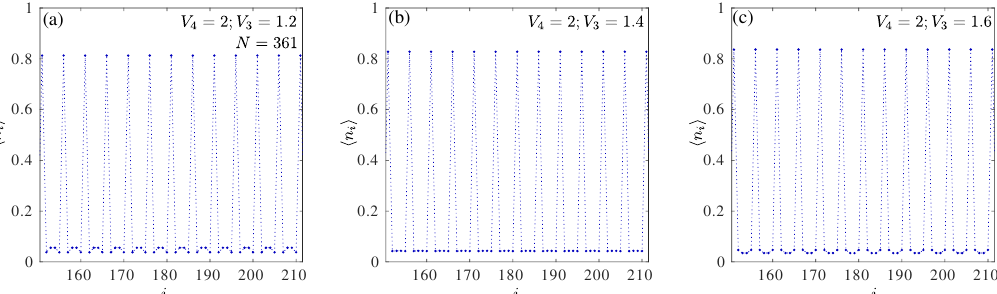
Figure 8: Average density ¯ n as a function of coupling constant V = 0.85 and (b) along the oblique cut V vertical cut at V 3 − V c | ¯ β with critical value V c of the fit ∝ | V 3 3 Talapov critical exponent ¯ β = 1 / 2.